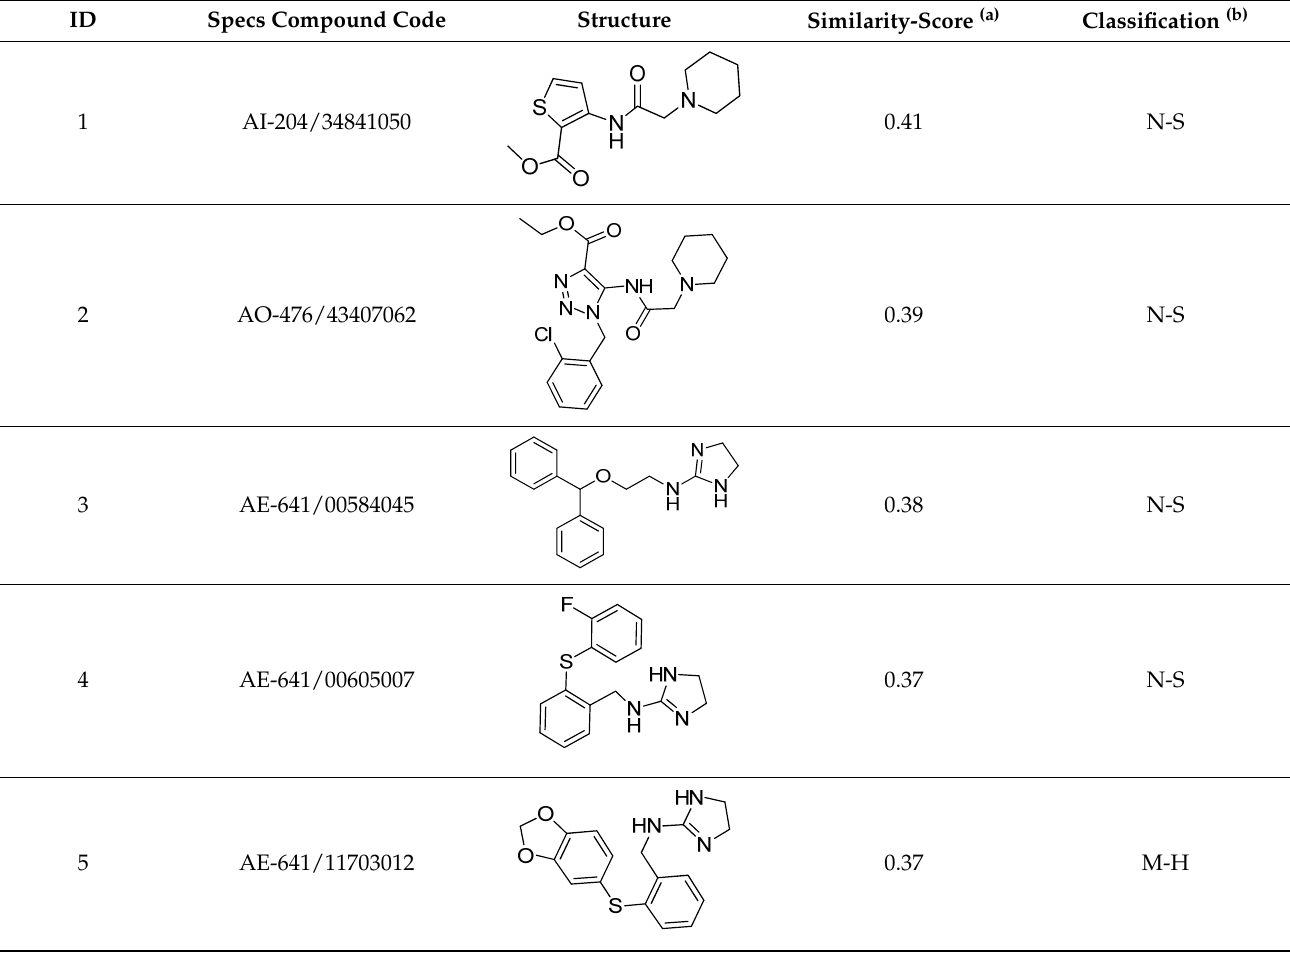
Table 2. List of 10 substrate candidates for the proton-antiporter, based on virtual screening results using the P1 pharmacophore as a template and classified by their substrate potency in hCMEC/D3 cells.